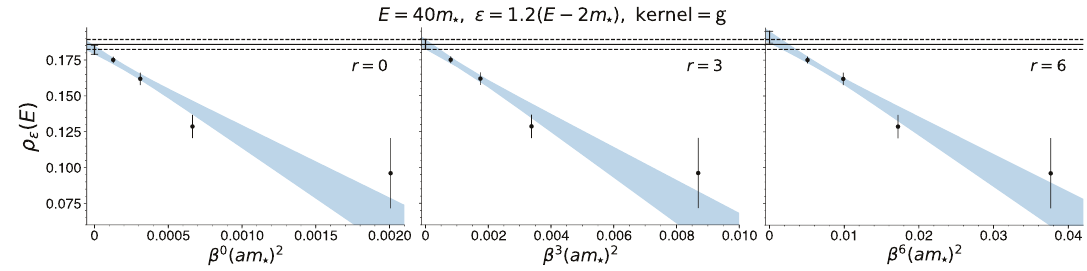
Figure 7 . The same as figure 5 for E = 40 m ? , (cid:15) = 1 . 2( E − 2 m ? ) , and the Gaussian smearing